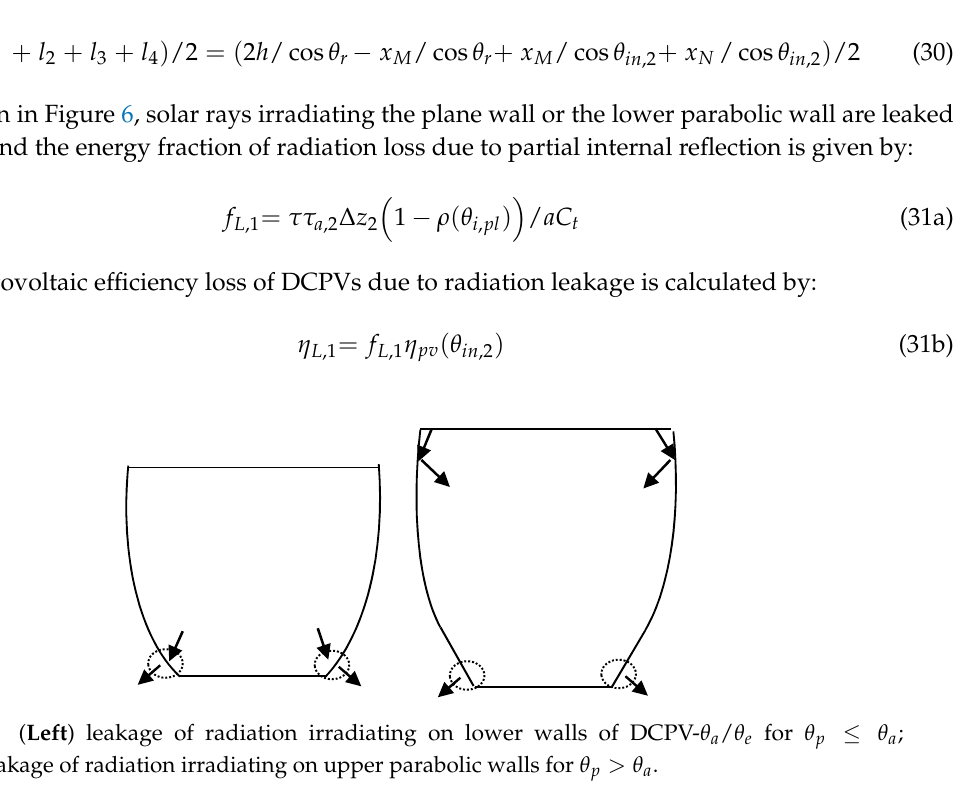
Figure 7. Irradiation situation of left plane wall as